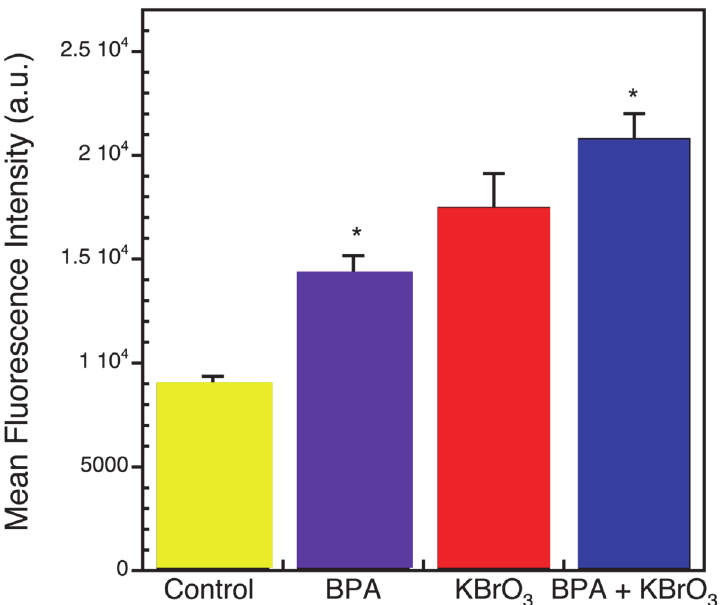
DNA lesion/ 10 6 DNA bases (mean ± SD, n (cid:3) 3) Ku70 -/- ThyGly